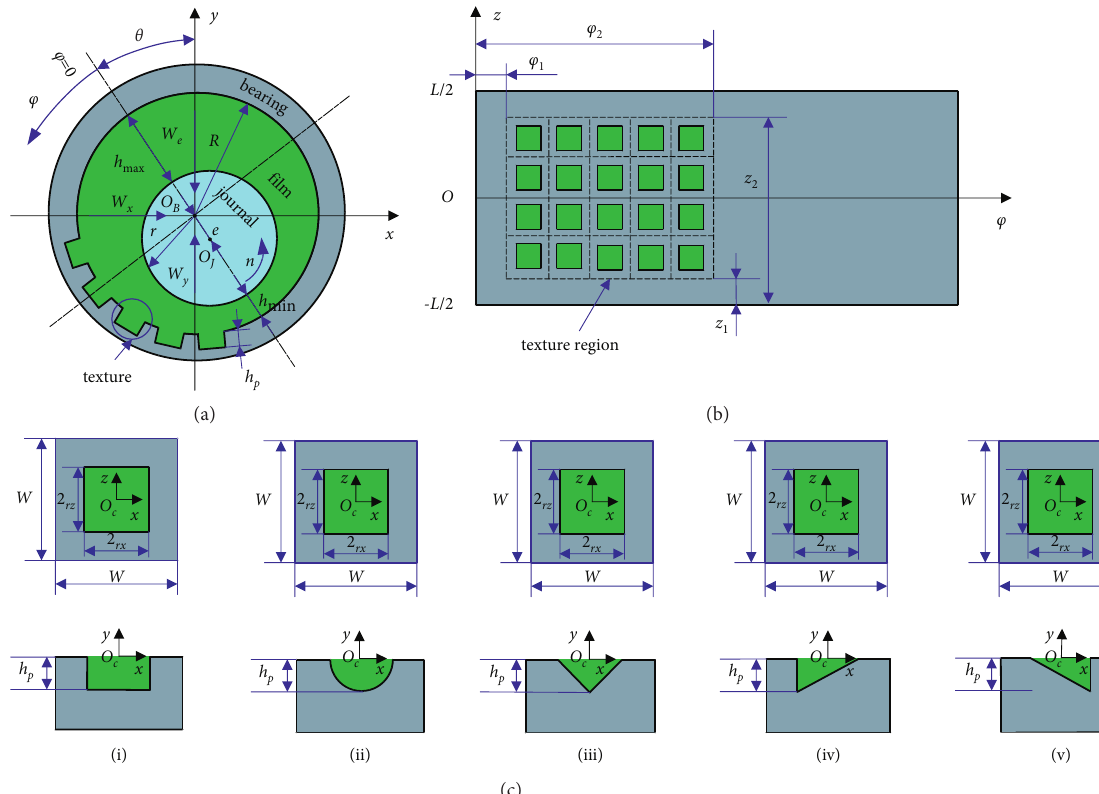
Figure 1: Schematic diagram of textured journal bearing: (a) the coordinate system; (b) the expanded surface of textured bearing; (c) the texture bottom profiles with (i) flat, (ii) curved, (iii) isosceles triangular T1, (iv) oblique triangular T2, and (v) oblique triangular